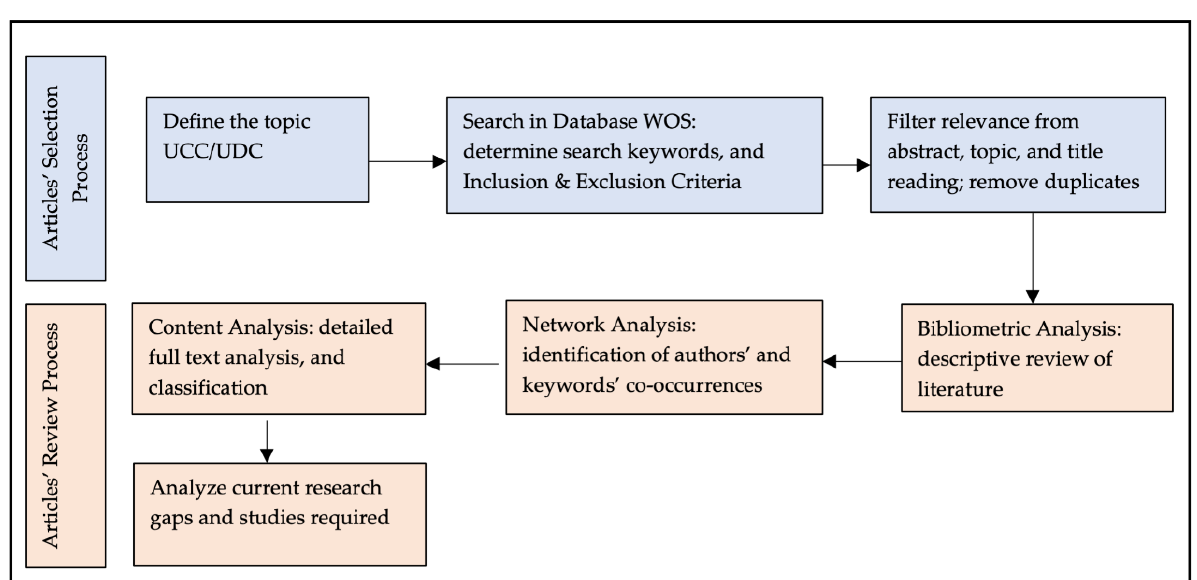
Figure 1. Systematic literature review: general processing steps.